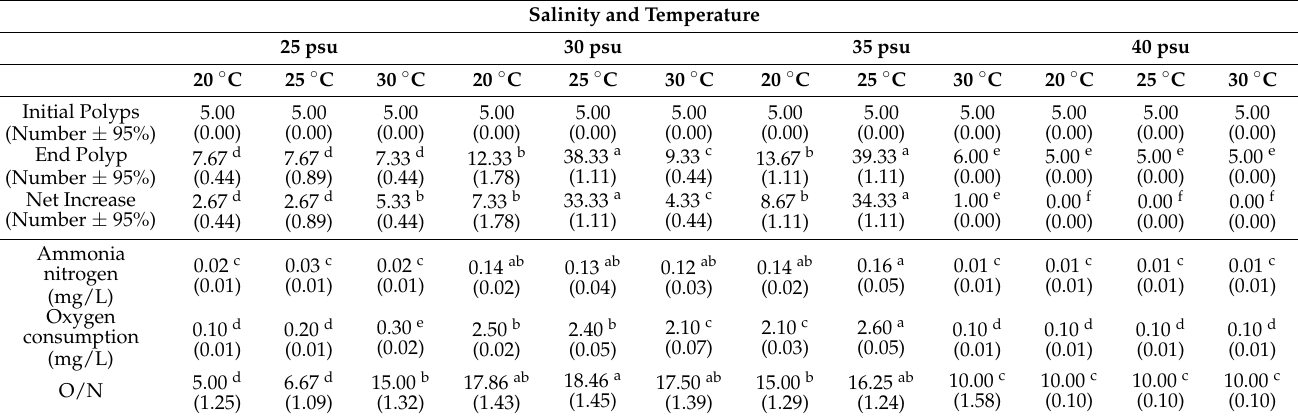
The superscript Latin alphabet to the right of values indicates horizontal comparisons, and showed significant differences ( p < 0.05). ± is SD ( n = 3).